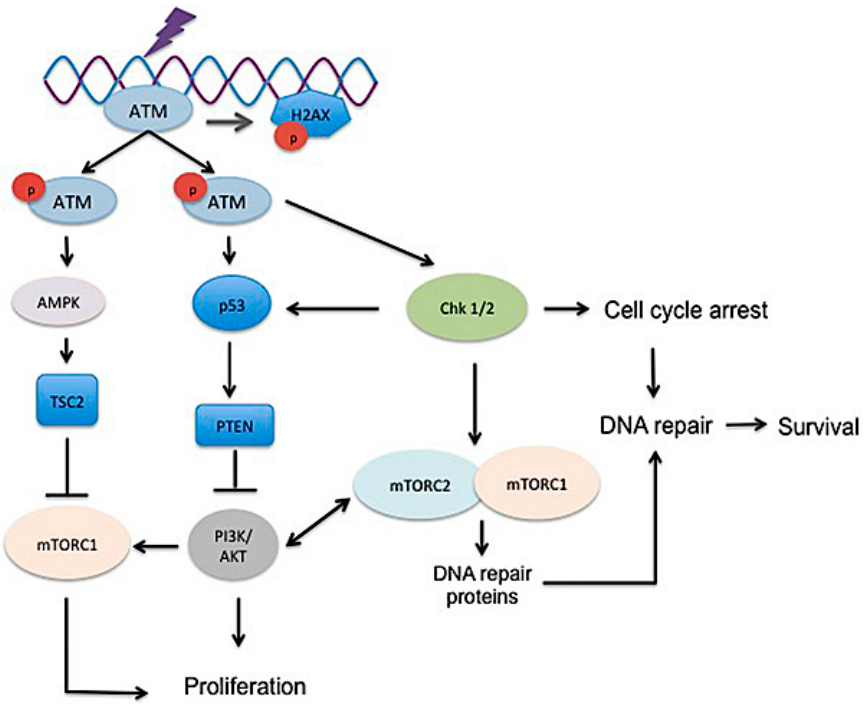
Figure 5. Proposed mechanism by which mTOR may contribute to radiosensitivity and DNA damage repair and thereby potential means in which inhibition of mTORC1 or mTORC2 may alter cell cycle arrest, DNA repair and cell survival following radiation. Pathologic pro-fibrotic lung fibroblasts may depend on both mTORC1 and mTORC2 for efficient cell cycle arrest and repair of DNA damage following radiation damage. In non-radiation induced lung damage, DNA damage may result from various chemical or other microinjuries that create a similar population of fibroblasts that depend on mTOR complexes for survival and proliferation. The bidirectional arrow indicates that AKT activates mTORC2 while mTORC2 can also positively impact PI3K/AKT signaling. T indicates the inhibition of the target molecule. The purple “bolt” indicates ionizing radiation.